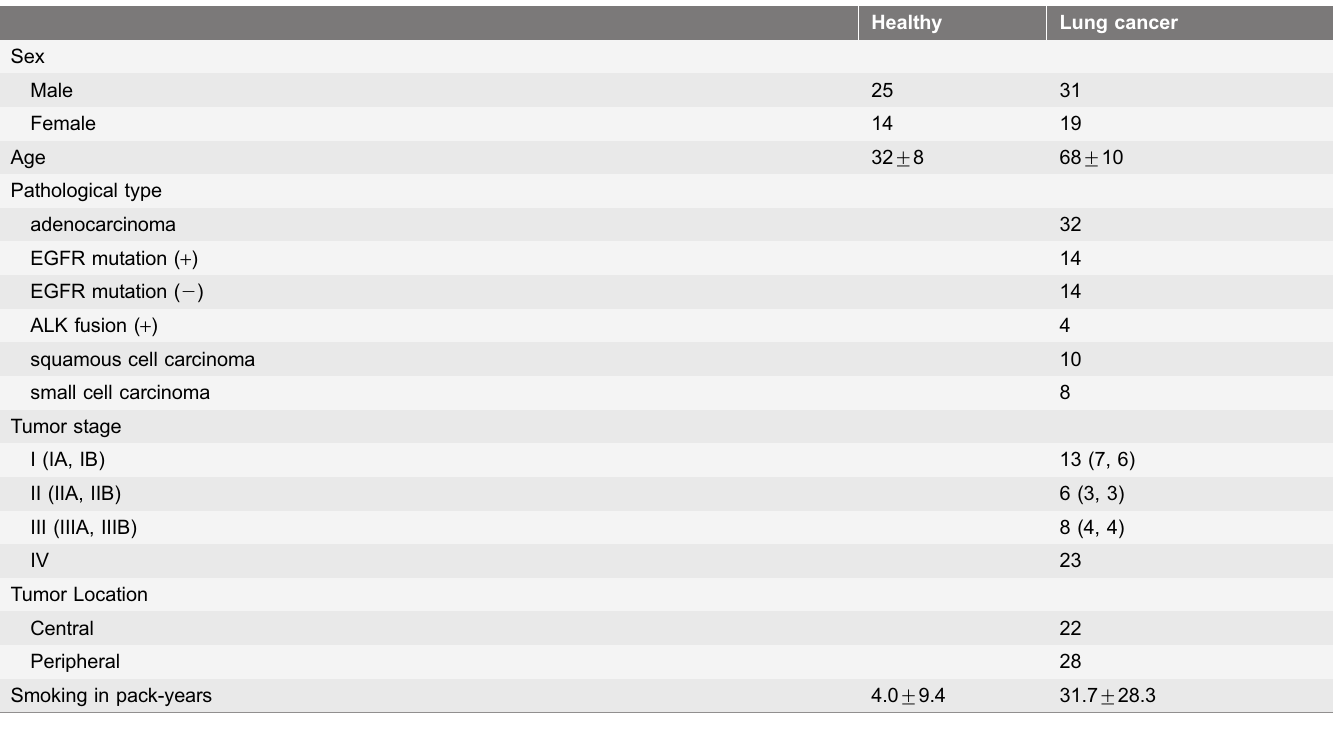
Table 2. Characteristics of patients.